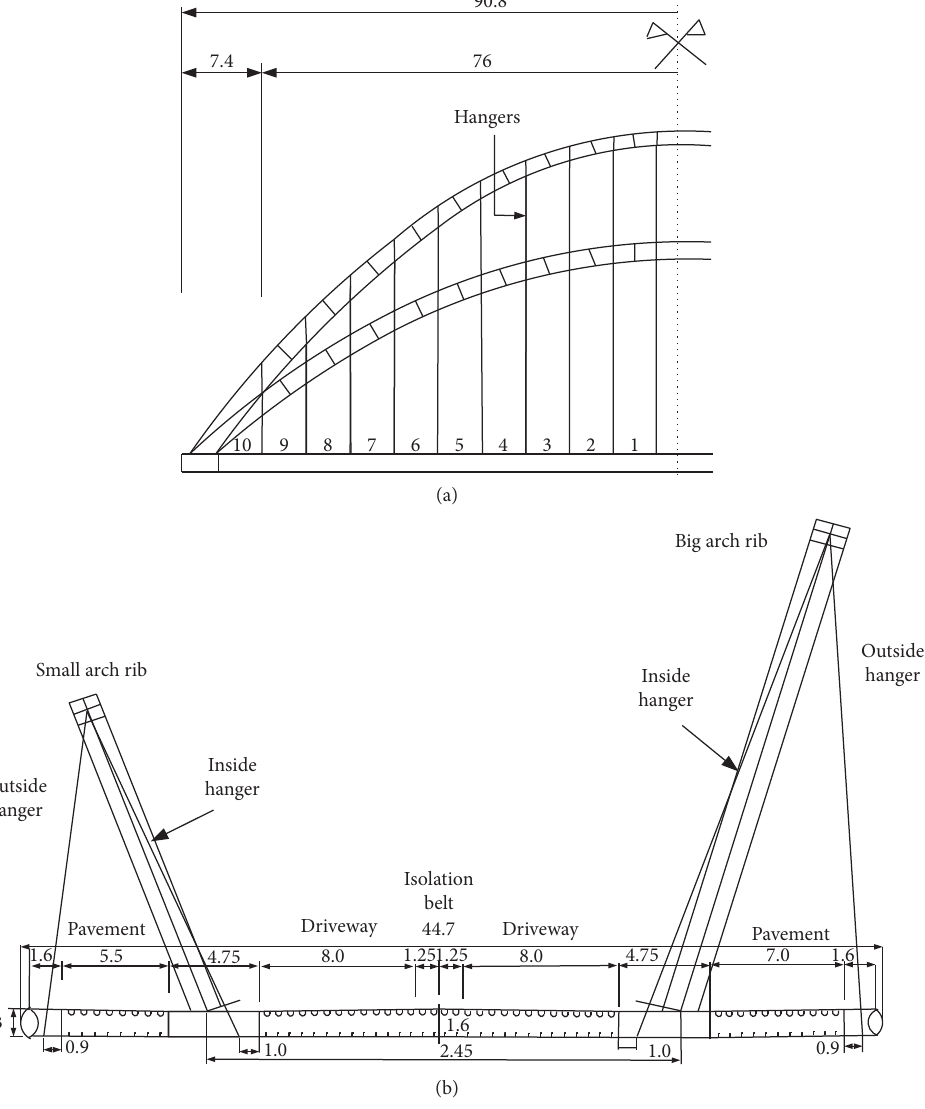
Figure 1: Details of the investigated bridge [38]. (a) Elevation. (b) Deck cross section at the center span.